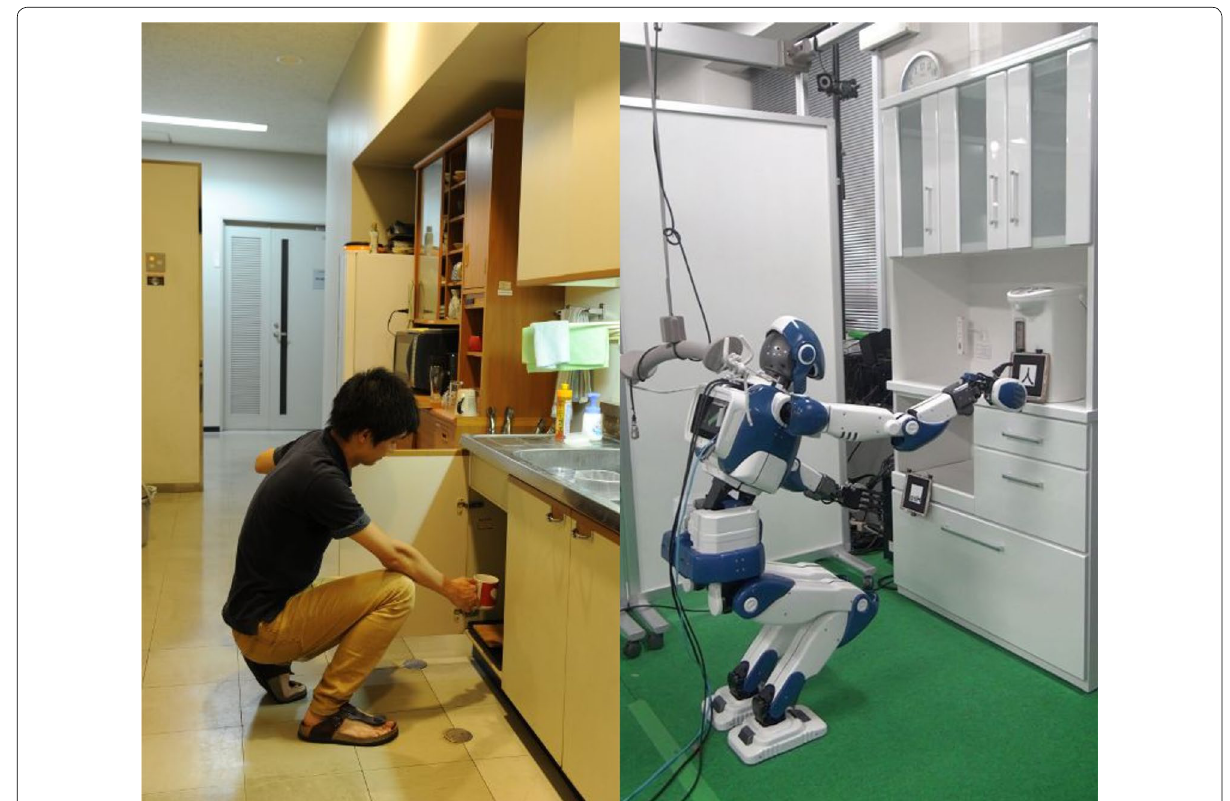
Fig. 1 Human (left) and humanoid robot (right) perform a manipulation task that requires hunkering down to reach the lower shelf in a